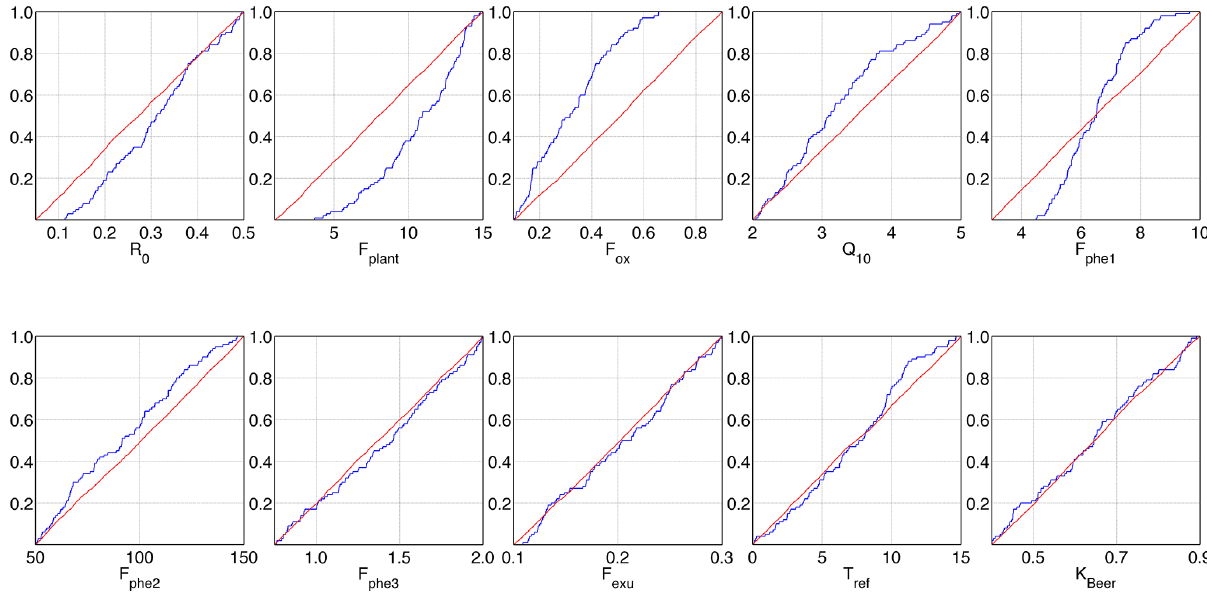
Figure 10. Deviations of cumulative distributions of parameters in CH 4 module (TW1), GPP calculated by method (ii). Blue: top 100 model performance. Red: all 3000 model runs. R 0 , CH 4 production rate factor; F plant , CH 4 plant transport rate factor; F ox , CH 4 plant oxidation factor; Q 10 , CH 4 production Q 10 factor; F phe1 , plant phenology factor, base for calculating heat sum; F phe2 , plant phenology factor, heat sum when maximum LAI is reached; F phe3 , plant phenology factor, maximum LAI; F exu , plant root exudate factor; T ref , reference temperature for decomposition; and K Beer , Beer’s law extinction